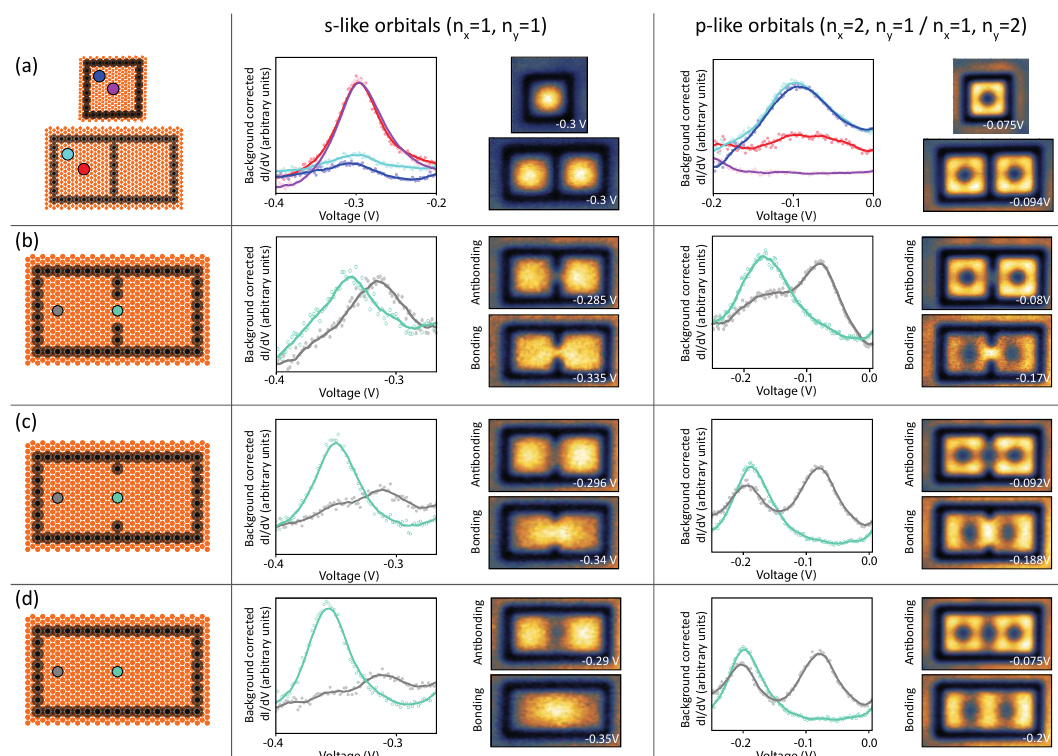
Figure 6: (a) From left to right, first the geometry of the coupled corral is shown. The second column demonstrates coupling of s -like orbitals: dI the positions indicated by the color code and corresponding dI indicated energies. The third column focuses on coupling of p -like